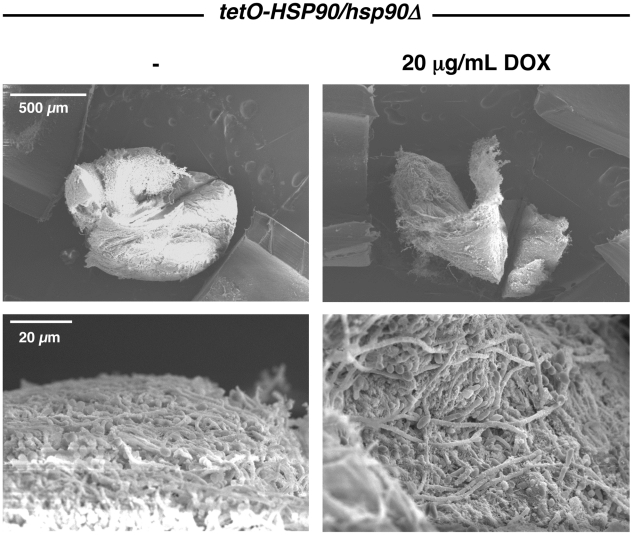
Genetic depletion of Hsp90 does not block C. albicans biofilm formation in vivo.The tetO-HSP90/hsp90Δ strain was inoculated in rat venous catheters in the presence or absence of 20 µg/mL doxycycline (DOX). Biofilms were examined by scanning electron microscopy imaging at 24 hours. The top row represents 50 X magnification while the bottom row represents 1,000 X magnification. Biofilm thickness and structure were similar in the presence or absence of doxycycline.